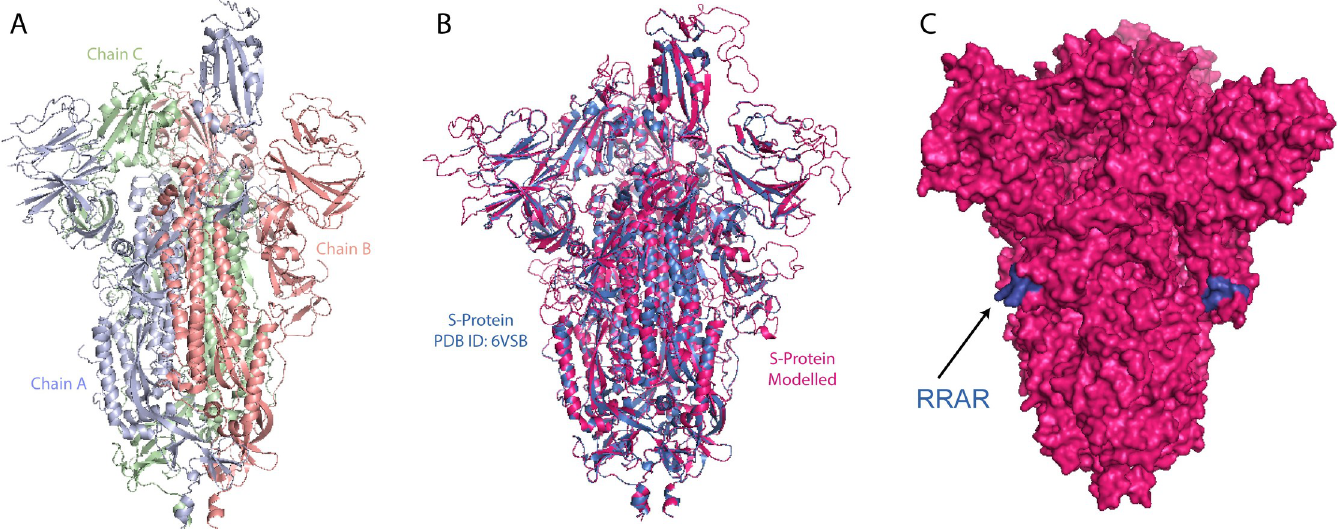
Fig 6. 3D modelling of SARS-CoV-2 Spike protein. (A) Trimeric structure of SARS-CoV-S spike like protein (PBD:6VSB). (B) Overlay of the SARS-CoV-S spike like protein (PBD ID: 6VSB, blue) with the modelled SARS-CoV-2 S protein (PDB ID: 6M71, magenta). (C) The surface of the modelled S protein with the RRAR furin cleavage site (blue).